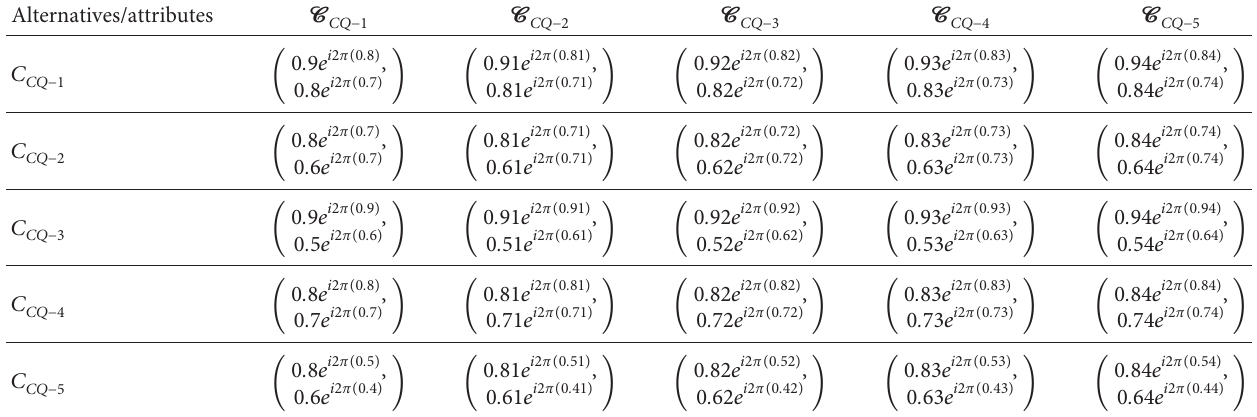
Table 1: Rating of the given alternatives for Example 1.